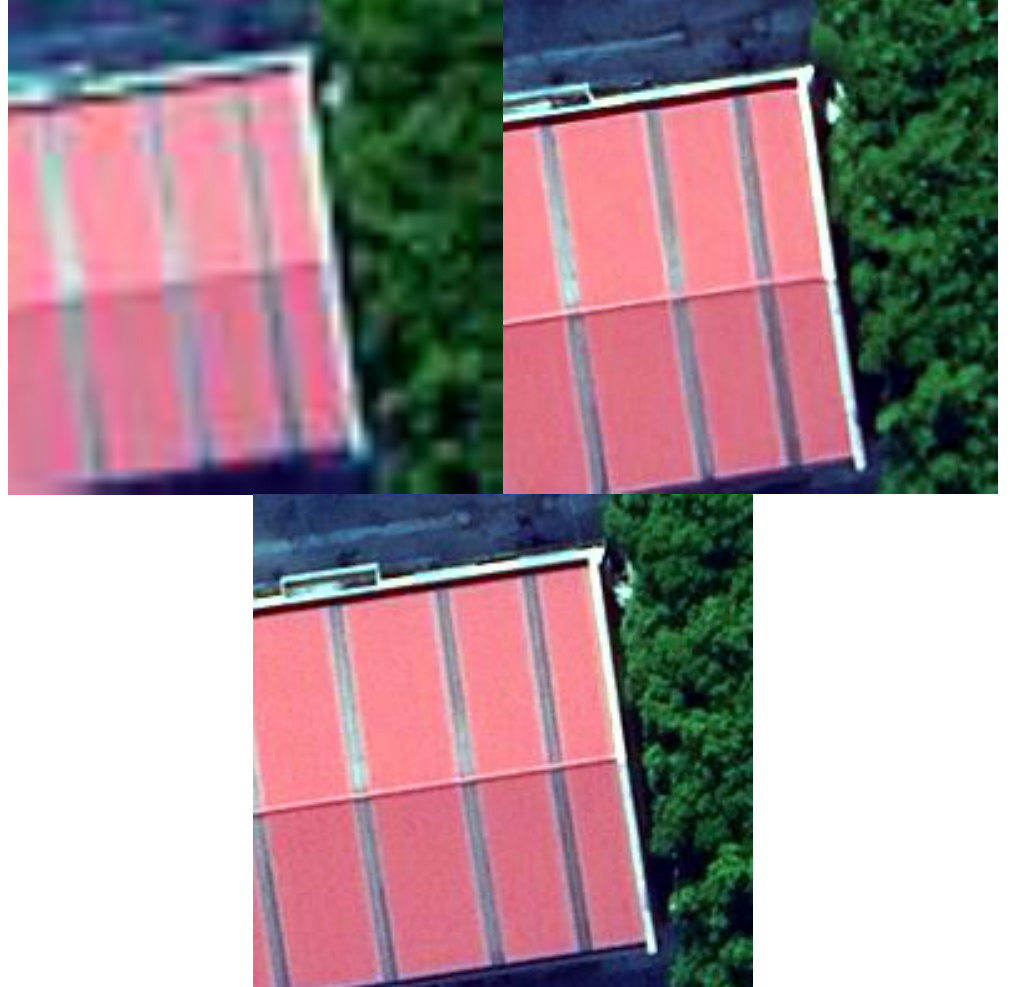
House in the aerial image